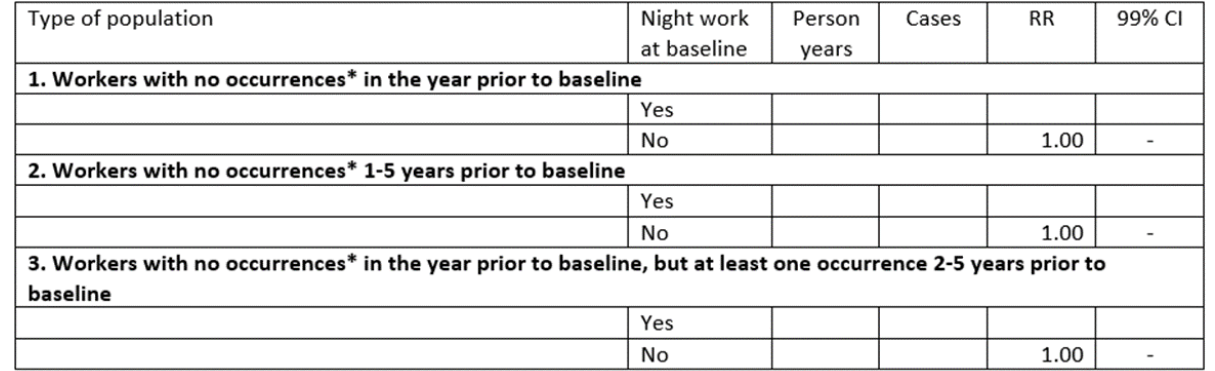
Figure 8. Dummy table: rate ratios (RRs) with 99% CIs for incident or recurrent use of psychotropic drugs, as a function of night work among employees in Denmark 2004-2013. Populations 2 and 3 are disjointed and exhaustive subsets of population 1. *The term occurrences refers to “occurrences of redeemed prescriptions for psychotropic medicine or psychiatric hospital treatment.”.